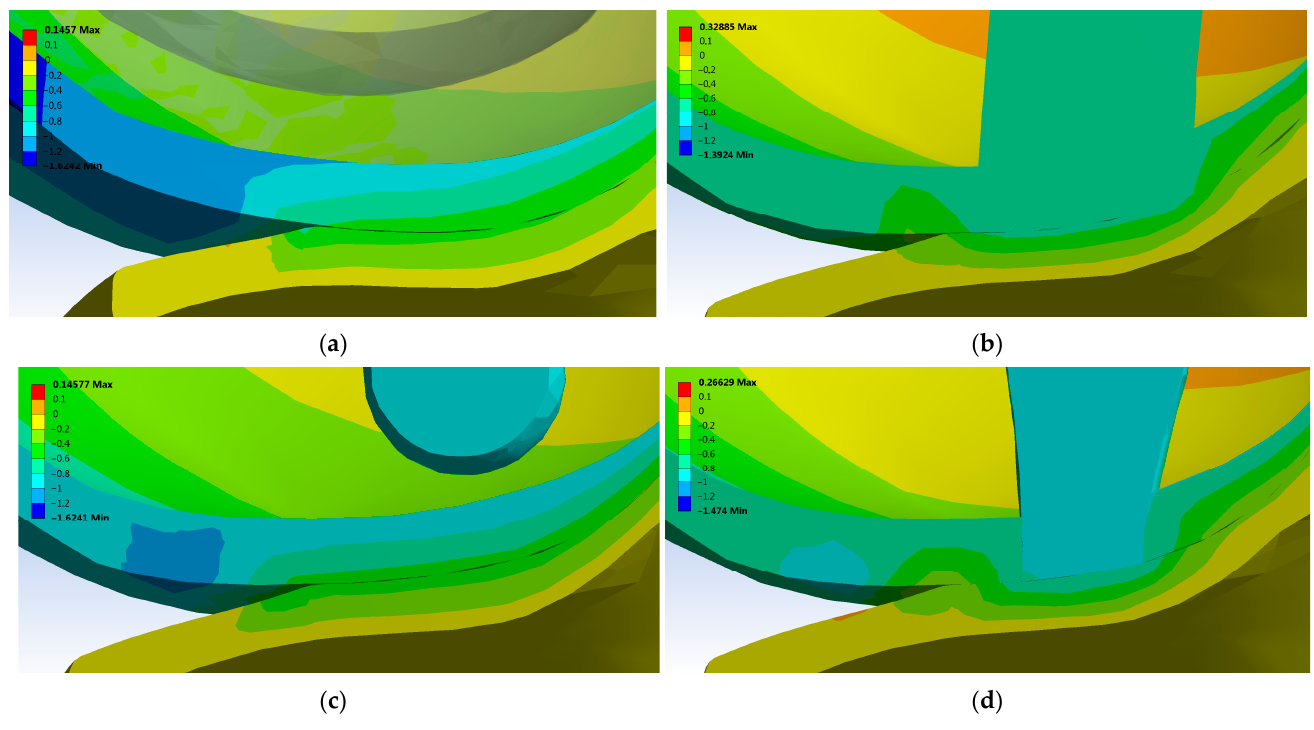
Figure 8. Directional deformation in Z axis of femoral and tibial cartilage after applying a normal pressure of 0.38 MPa: ( a ) Case 0 (healthy knee); ( b ) Case 1 (just porous Collagen); ( c ) Case 2 (Collagen + BMC); ( d ) Case 3 (Collagen + ASC).